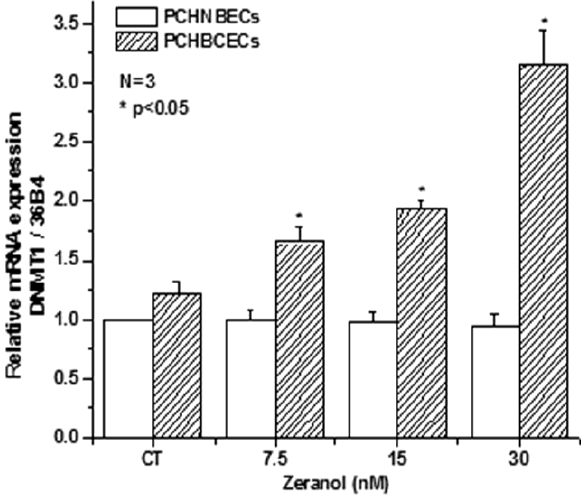
Figure 3. Effects of Z on regulation of the expression of DNMT1 mRNA in PCHBCECs and PCHNBECs. The expression levels of DNMT1 mRNA were evaluated in PCHBCECs and PCHNBECs after treatment with vehicle control or 7.5–30 nM Z using real time PCR analysis. 36B4 was used as an internal control. The mRNA ratios of DNMT1 to 36B4 were calculated using the ΔΔ Ct method. The asterisks show statistically significant differences between Z treatment groups and the control groups ( p < 0.05).